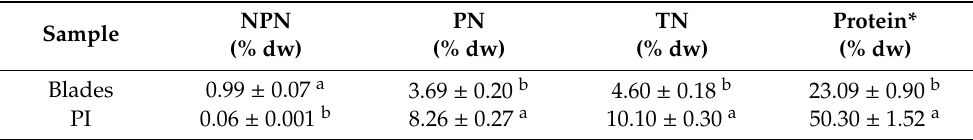
Table 1. Total nitrogen, non-protein nitrogen, protein nitrogen, and protein content of blades and protein isolate (PI) from Porphyra